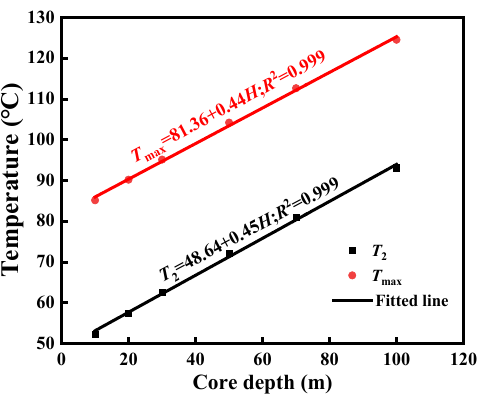
Figure 18. Maximum temperature of measuring point at different core depths in GHS.